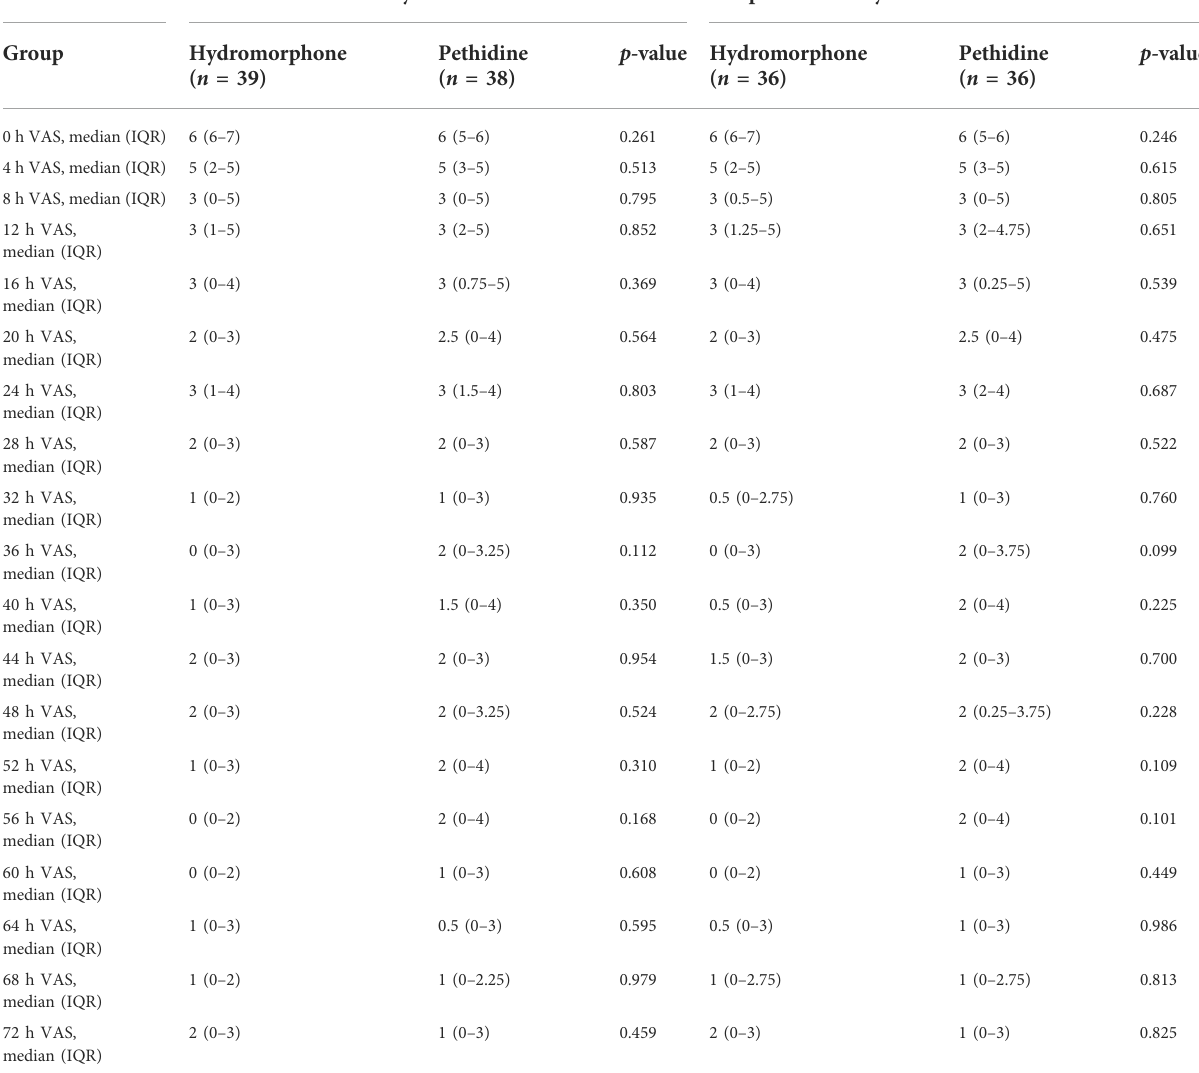
TABLE 2 VAS score trends over 72 h based on intention-to-treat and per-protocol analyses. Parameters Intention-to-treat